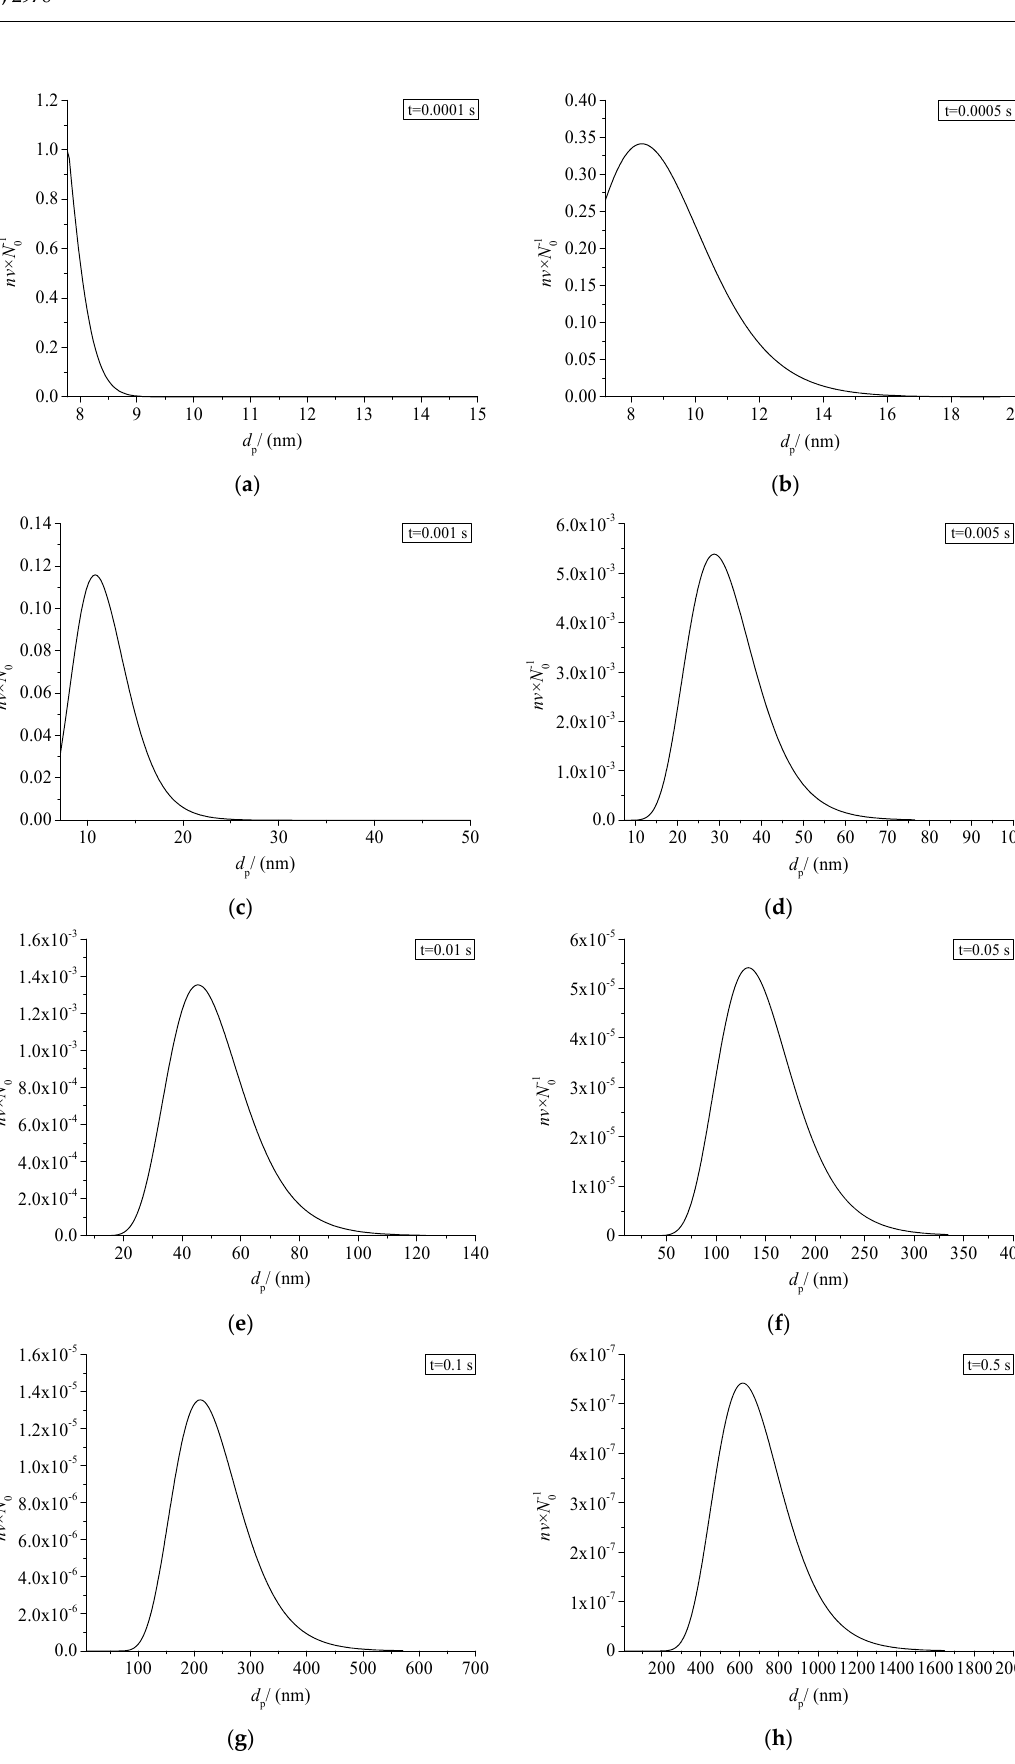
Figure 19. Sulfur particle size distribution at different time ( nv / N 0 ).